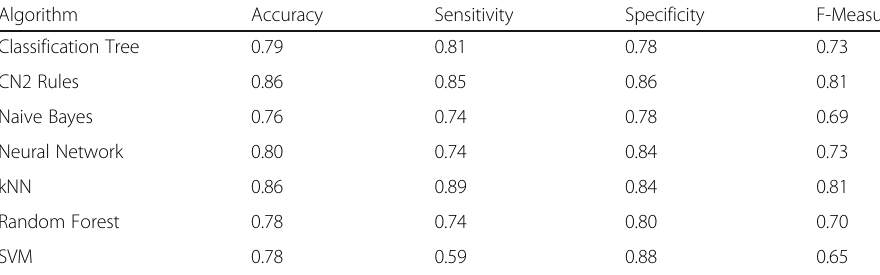
Table 8 Data Transformation: Equal Width, Feature Selection: Gini Index